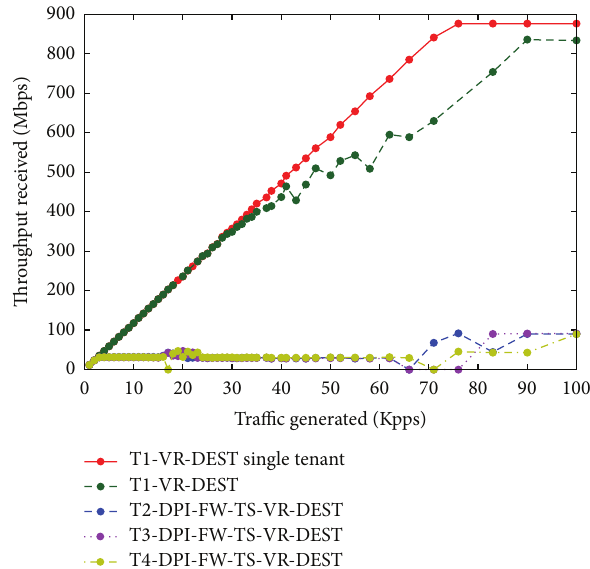
Figure 18: Received throughput versus generated packet rate for each tenant (T1, T2, T3, and T4) when T1 does not traverse the VNF chain of Figure 7(d), with 1500 -byte IP packet size. Comparison with the single tenant case. DPI: deep packet inspection; FW: fire-